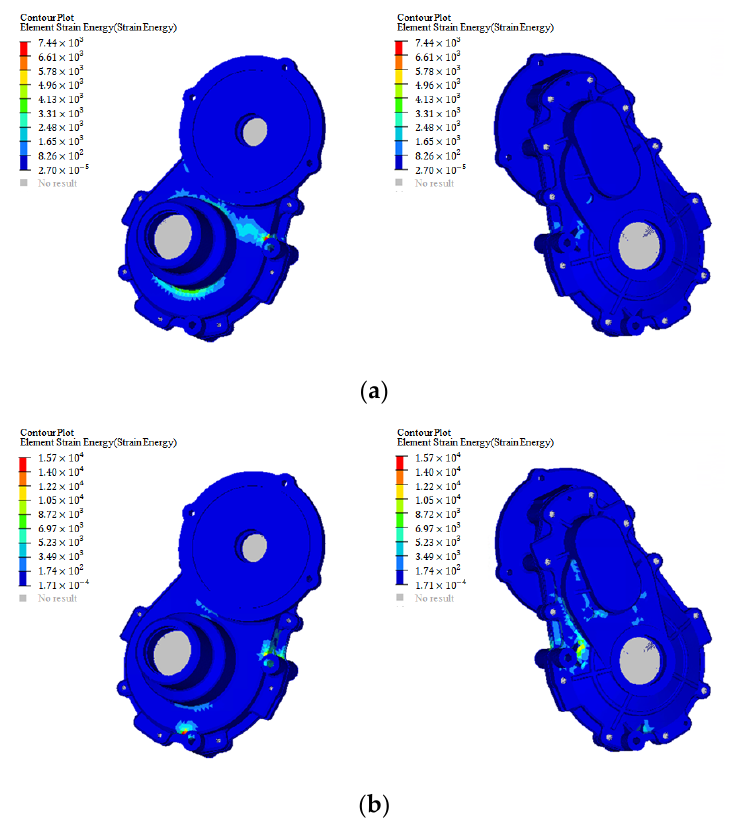
Figure 15. Elastic strain energy for counterclockwise drive. ( a ): ESE of mode shape at 885 Hz; ( b ): ESE of mode shape at 1280 Hz.